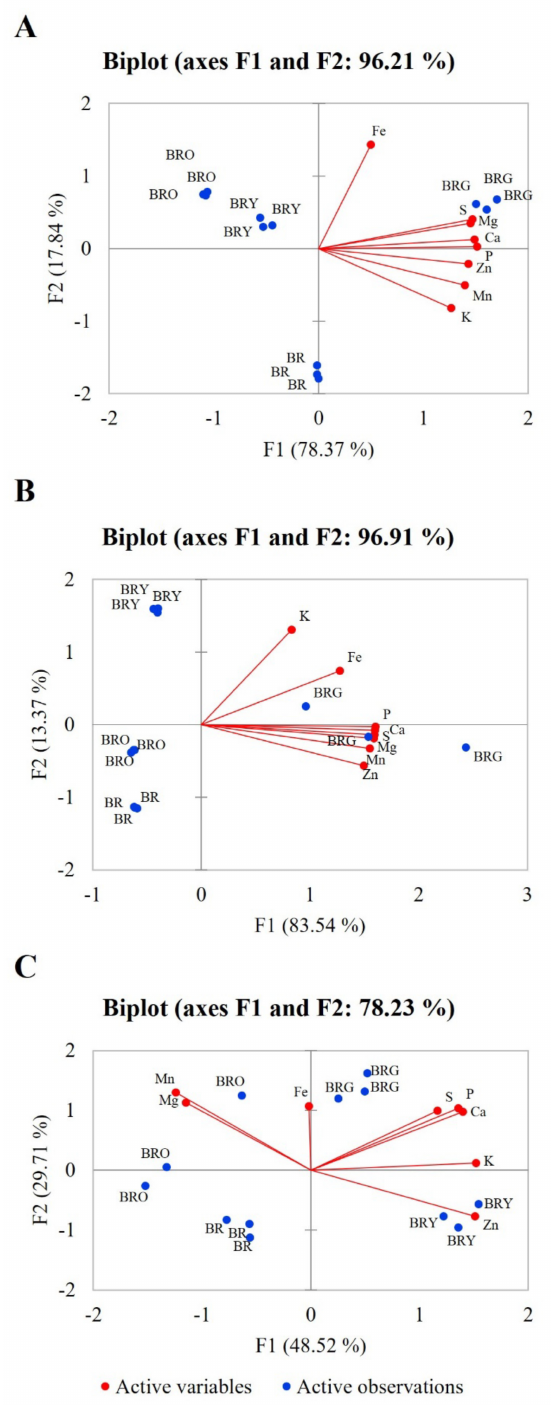
Figure 3. The PCA biplots, indicating distinct differences in mineral elements in mustard ( A ), beet ( B ), and basil ( C ) microgreens. BR—blue (peak = 447 nm), red (peaks = 638 and 665 nm), far-red (peak = 731 nm); BRG—BR with green (peak = 520 nm); BRY—BR with yellow (peak = 595 nm); BRO—BR with orange (peak = 622